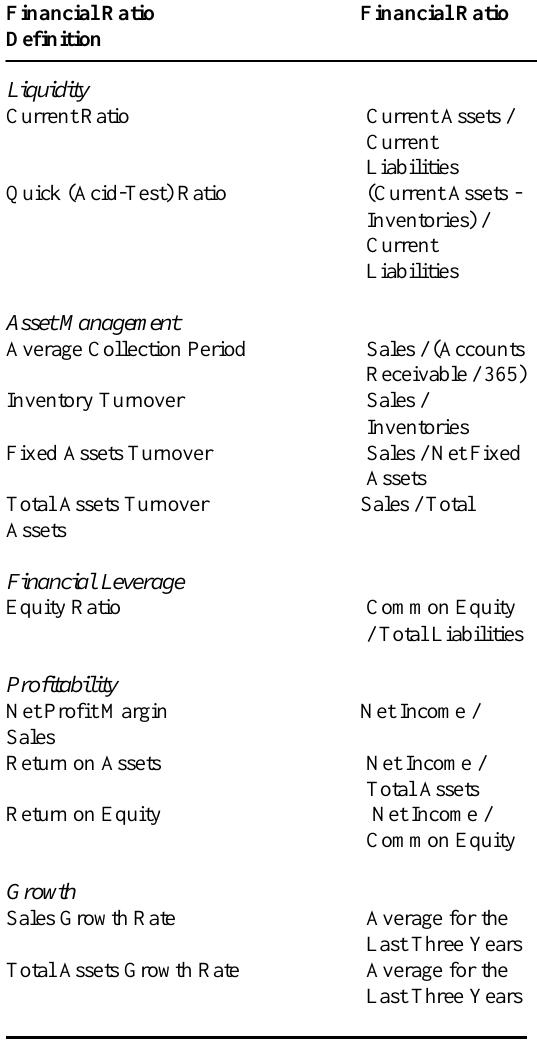
Table 5: Financial Ratios Used in the Study as Measures of Firm Financial